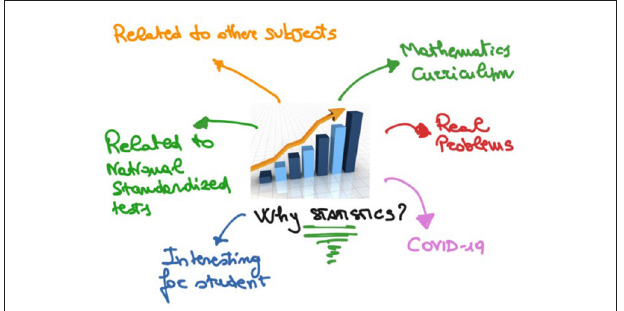
FIGURE 4 | Needs and educational proposals for statistics as LS